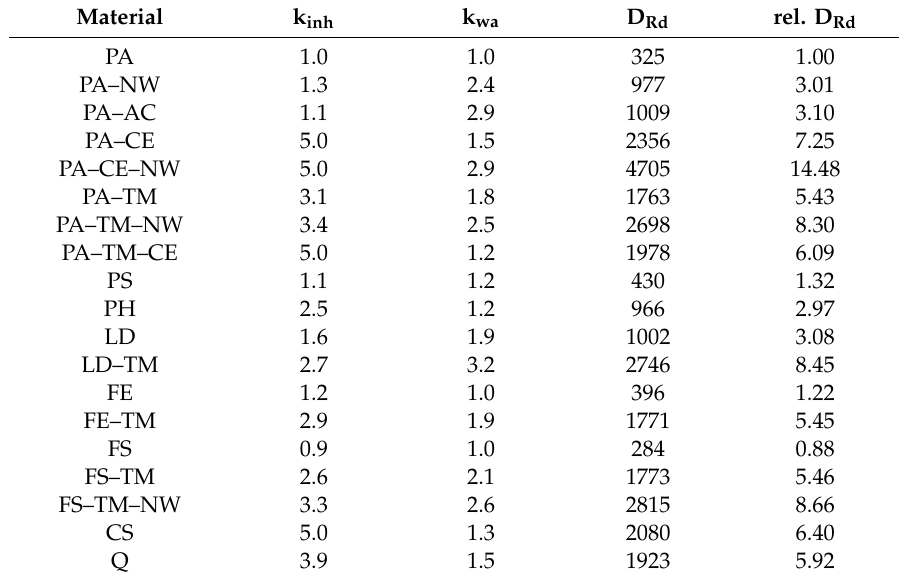
Table 3. Material resistance dose D Rd and MC data for k inh and k wa calculated based on the Meyer-Veltrup et al. (2018) methodology